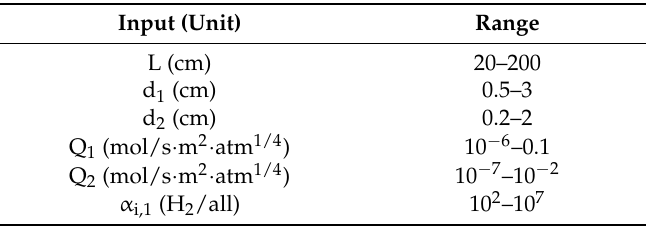
Table 3. Sensitivity study input variable